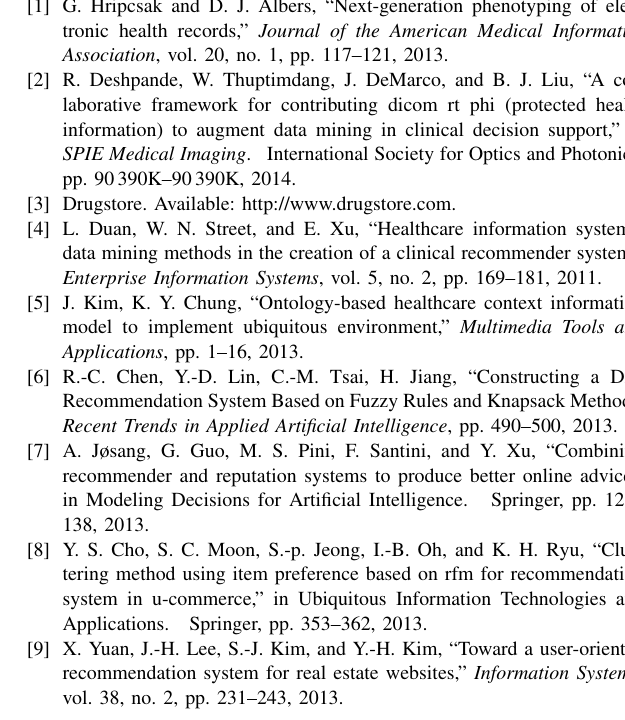
Fig. 7. The F1 index of Tensor and